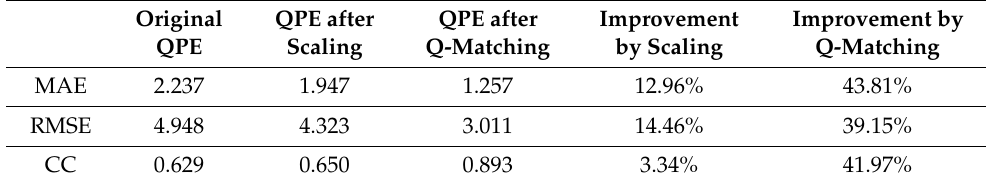
Table 1. The results of MAE, RMSE error, and CC of hourly radar QPE products compared to AWS rain observations. The results and improvement percentages are also given after the scaling and Q-matching methods were implemented, respectively. The units for MAE and RMSE are mm/h. Original QPE after QPE after Improvement Improvement by QPE Scaling Q-Matching by Scaling Q-Matching